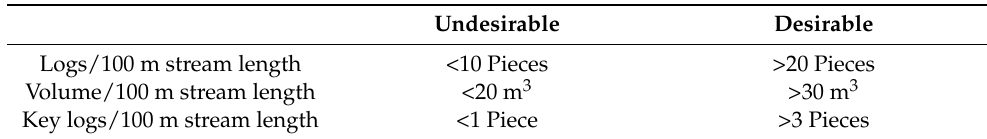
Table 1. LW benchmarks based on Thom et al. 2000 (Logs refer to LW with diameter > 15 cm and length > 3 m, key logs refer to diameter > 60 cm and length > 10 m)